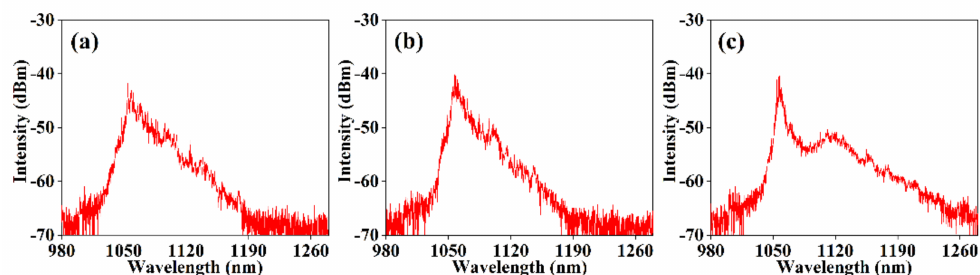
Figure 8. Measured output spectra from MMFs with tapered length of ( a ) 1.7 cm, ( b ) 3.6 cm, and ( c ) 5.0 cm at the input peak power of 507.9